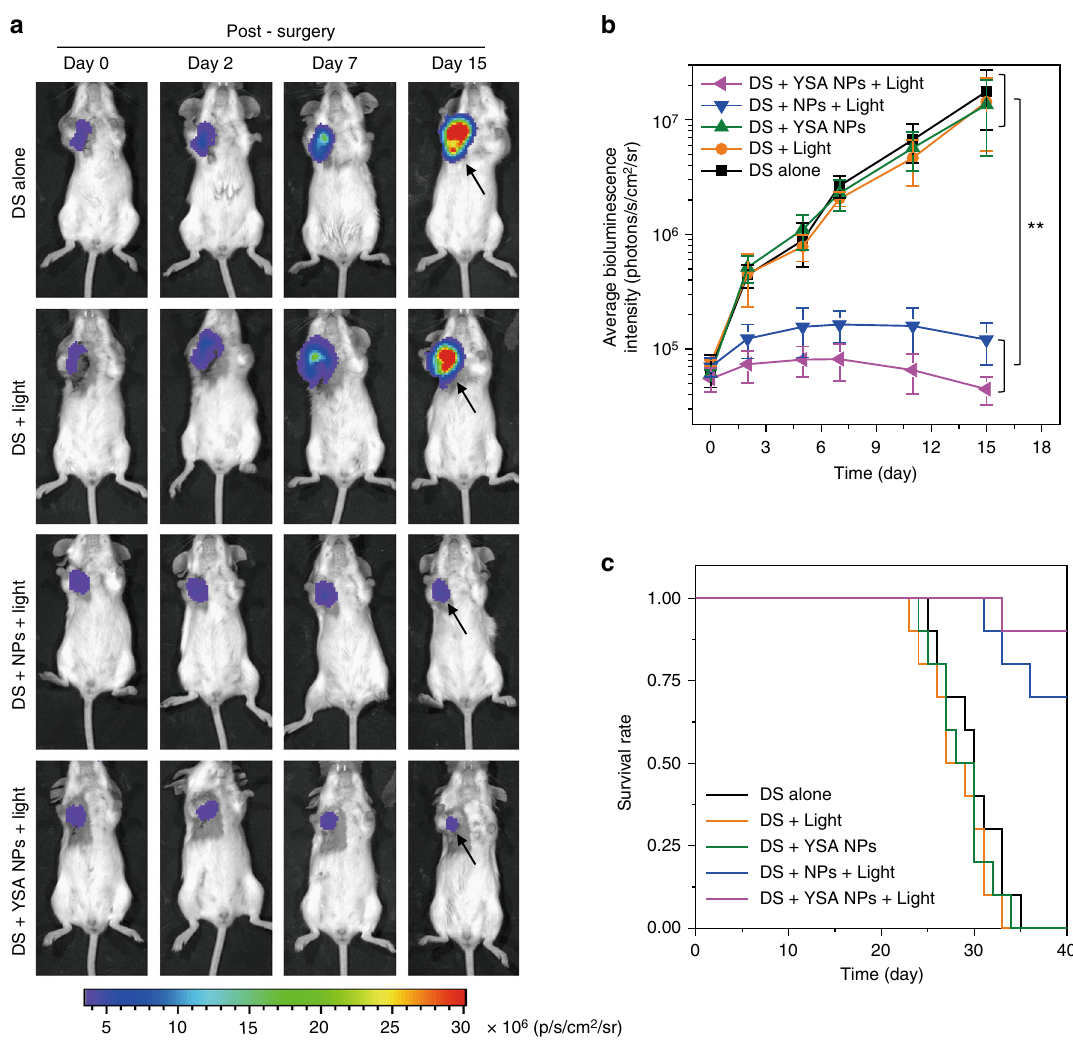
Fig. 7 In vivo PDT of residual tumours after debulking surgery (DS). a Time-dependent bioluminescence imaging of residual tumours from mice in different groups. The tumours were debulked on day 0. The 4T1 cancer cells express luciferase, permitting bioluminescence imaging. The black arrows indicate the residual tumours. b Quantitative analysis of bioluminescence intensities of residual tumours from mice with various treatments as indicated. Error bars, mean ± s.d. ( n = 10 mice per group). ** P < 0.01, one-way ANOVA. c Survival curves for different groups ( n = 10 mice per